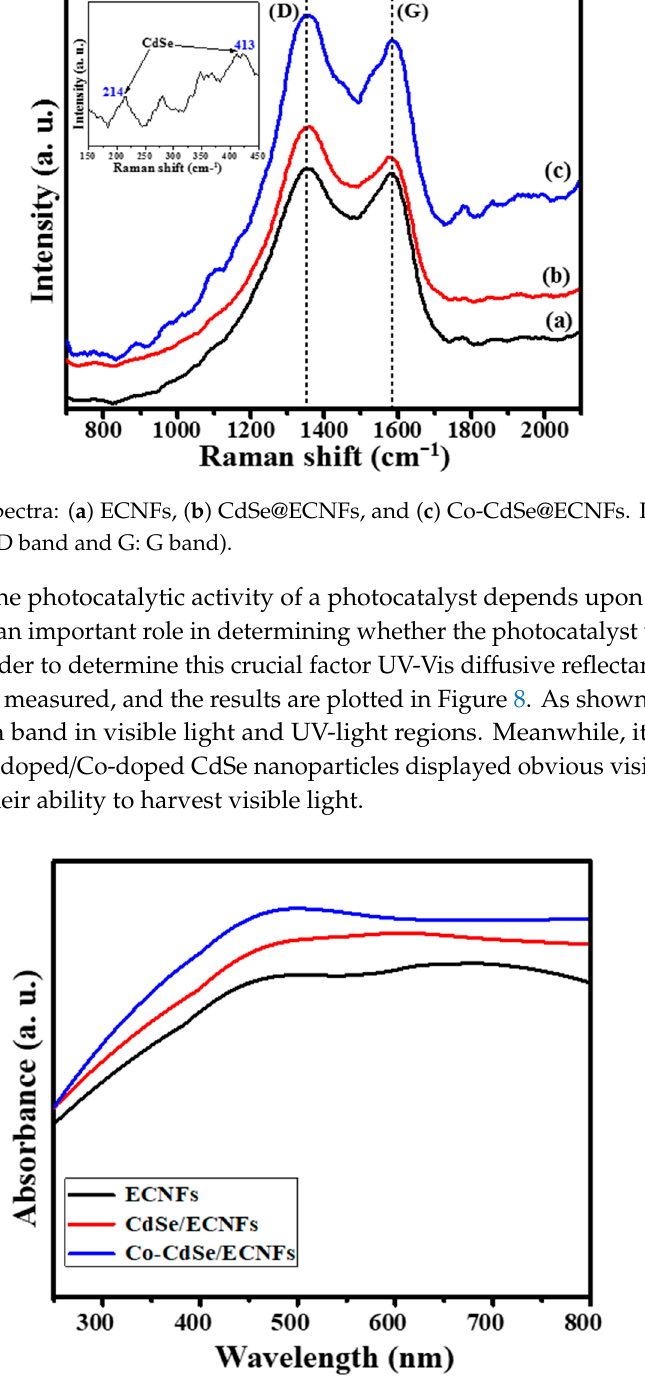
ff usive reflectance Figure 8. UV-Vis diffusive reflectance spectra. Figure 8. UV-Vis di Figure 8. UV-Vis diffusive reflectance spectra.